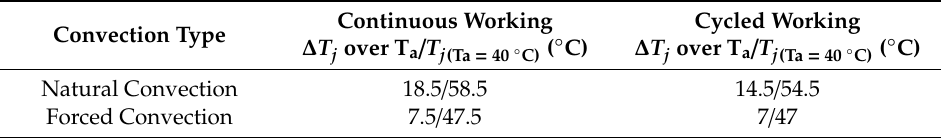
Figure 2. The junction temperature ( T j ) of the UV LED was measured at T a = 40 °C for natural convection and forced convection, and for the continuous and cycled (30 s on/30 s off) working modes. Continuous and cycled Tj under natural convection is shown in red and orange; T j under forced convection is shown in light and dark blue. Table 1. Increased Tj of UV LED over any ambient temperature value, and absolute Tj value for T a = 40 ◦ C, in natural and forced convection and continuous and cycled working